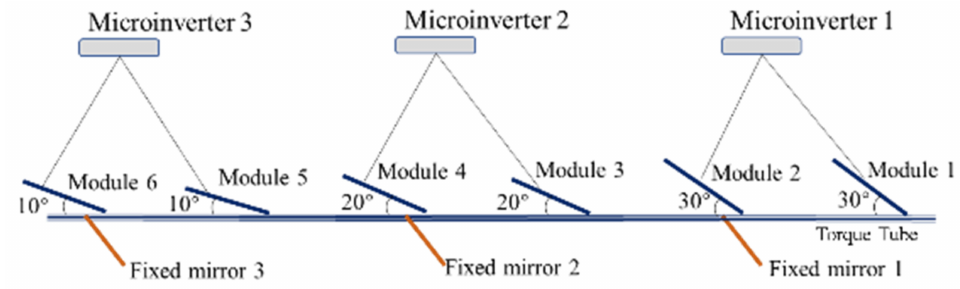
Figure 11. Test structure and wiring